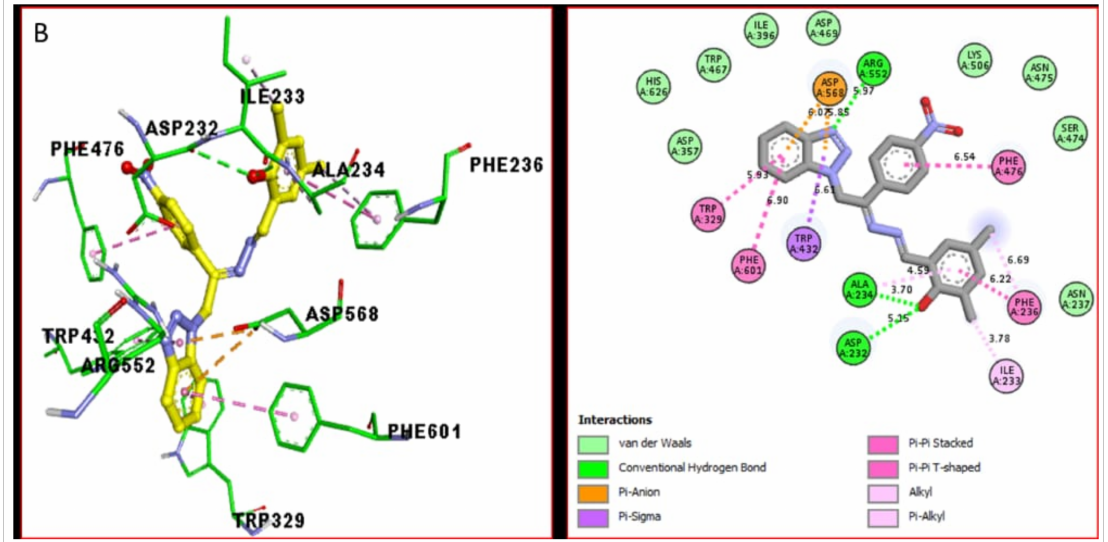
Figure 7. The protein-ligand interaction (PLI) profile of the second most potent compound 10. ( B ) for compound 10 against the α -glucosidase